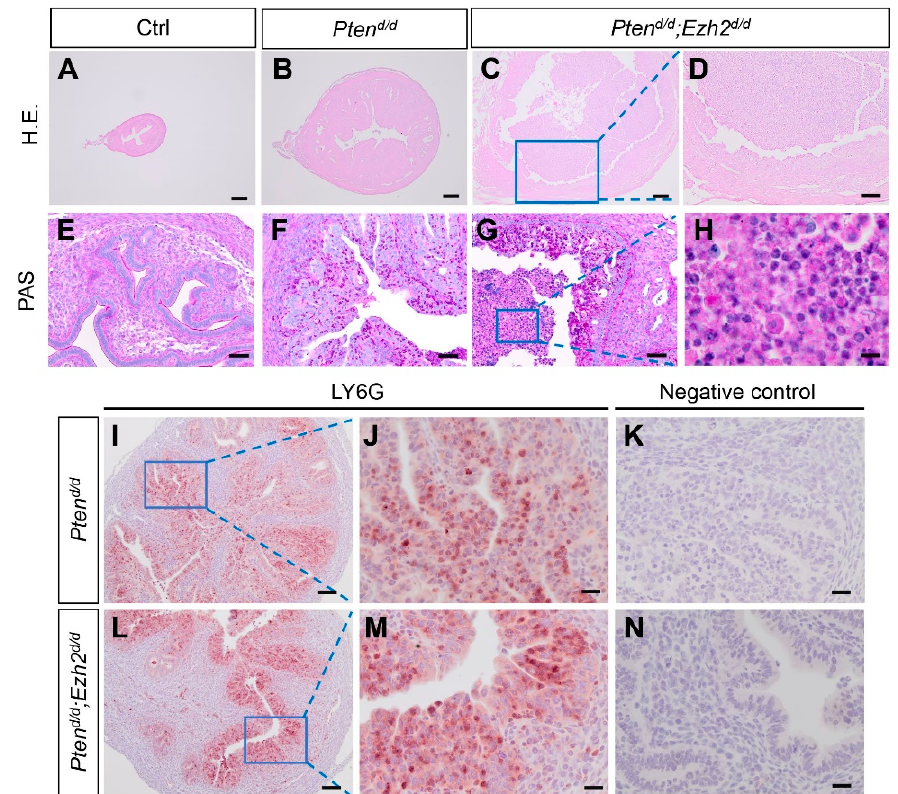
Figure 3. Deletion of Ezh2 promotes accumulation of intraluminal neutrophils in PTEN-inactivated uteri. ( A – H ) Histological analyses of uteri from 1-month-old Pten f/f , Pten d/d , and Pten d/d ; Ezh2 d/d mice using H.E. staining ( A – D ) and PAS staining ( E – H ). Panels ( D , H ) are high power images of the boxed areas of panels ( C , G ), respectively. ( I – N ) Immunostaining of LY6G using uteri from three-week-old Pten d/d and Pten d/d ; Ezh2 d/d mice. Panels ( J , M ) are high power images of the boxed areas of panels ( I , L ), respectively. Panels ( K , N ) are negative controls where the primary antibody was replaced by isotype-matched IgG. At least three independent samples per genotype were examined. Scale bar = 10 µm ( H ), 20 µm ( J , K , M , N ), 50 µm ( E – G ), 100 µm ( D , I , L ), and 200 µm ( A – C ).